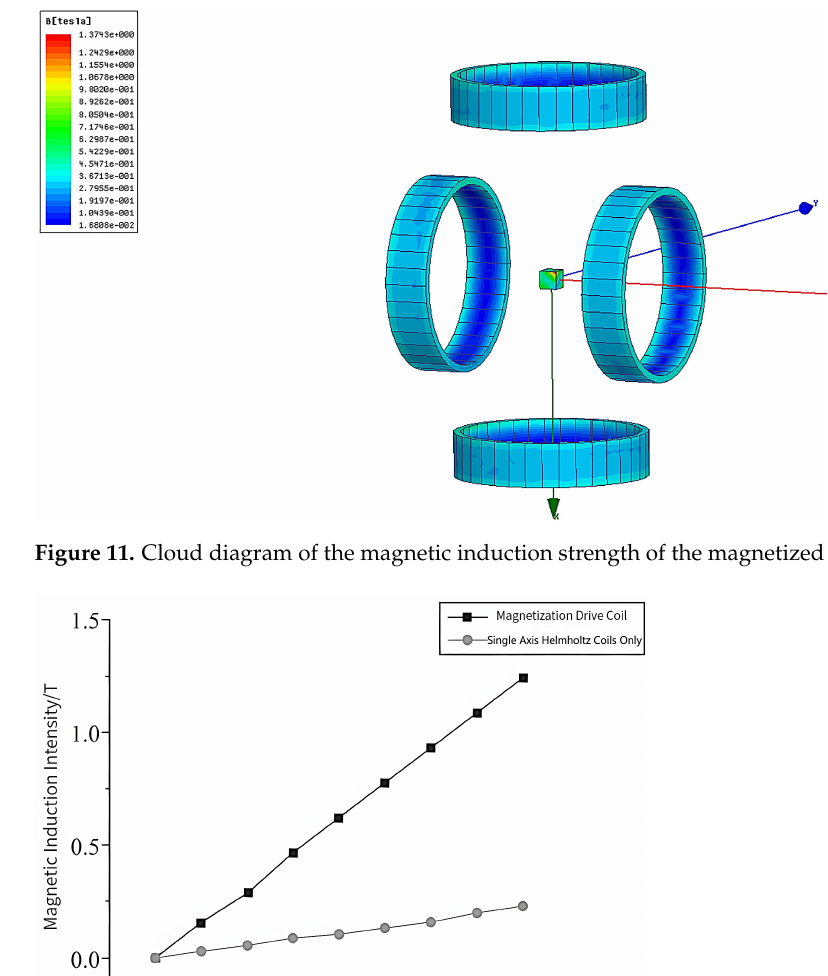
Figure 10. Cloud diagram of the Helmholtz coil magnetic induction intensity.